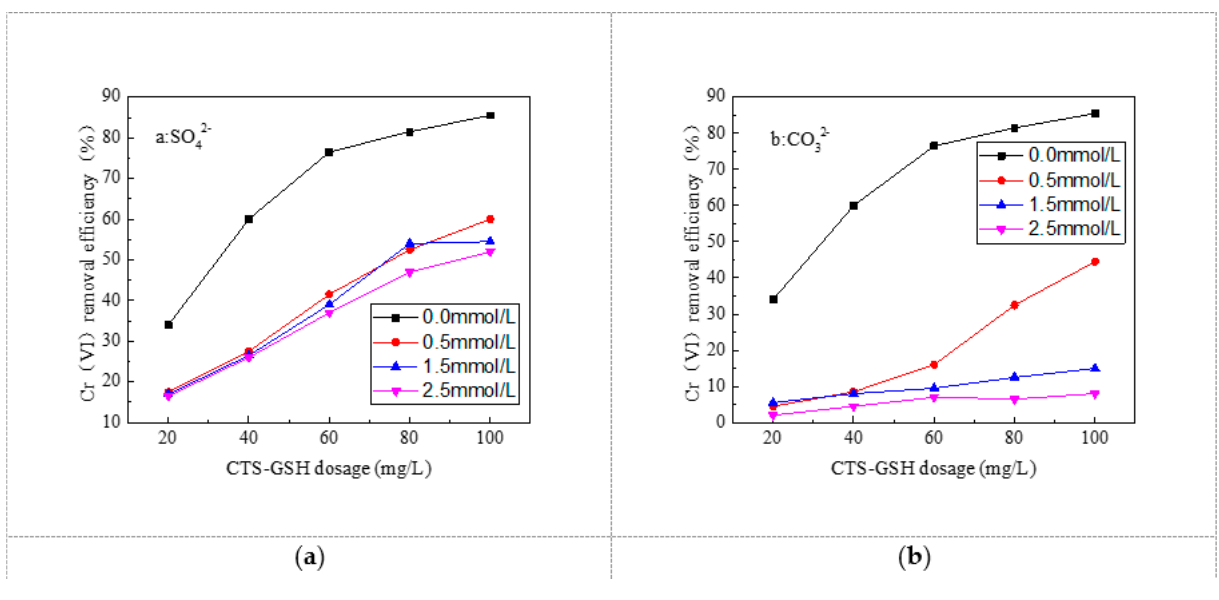
Figure 11. Effect of anions on Cr(VI) removal. ( a ) Effect of SO 42 − on Cr(VI) removal. ( b ) Effect of CO 32 − on Cr( Ⅵ ) removal.